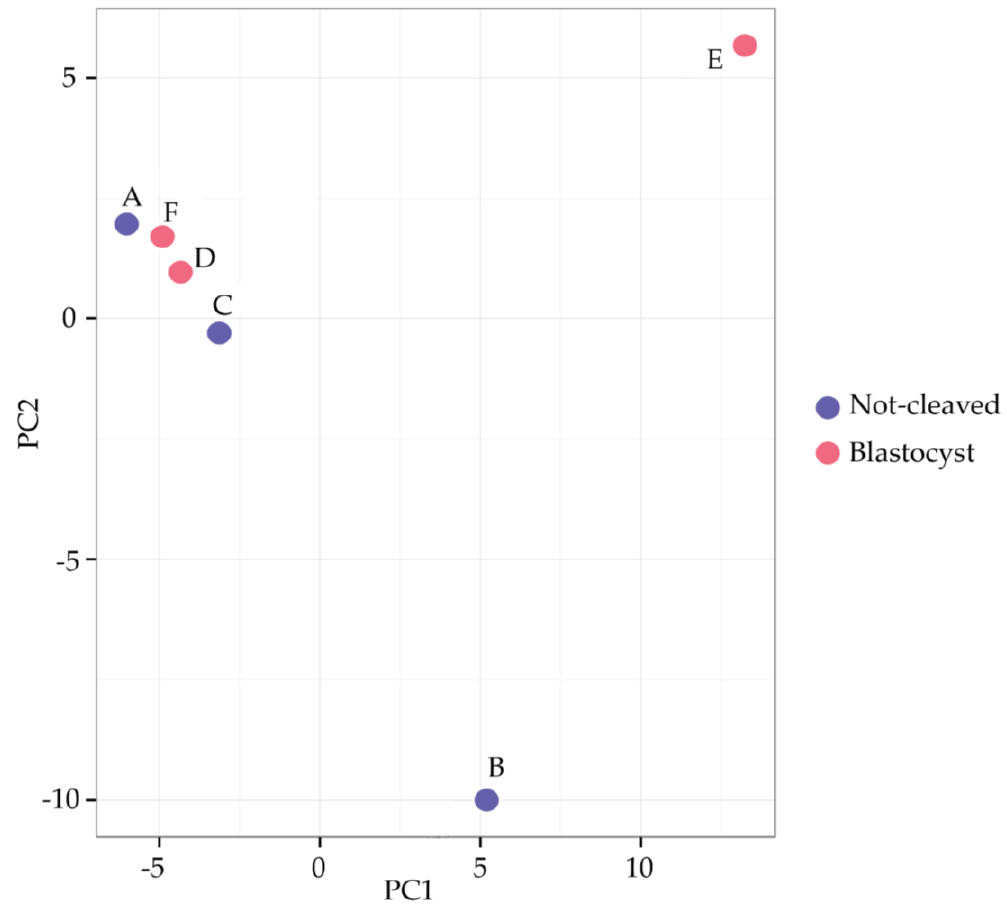
Figure 4. Principal component analysis (PCA) plot. The PCA was performed using the 50 miRNAs that had the largest variation across all samples. The features have been shifted to be zero centered (i.e., the mean value across samples was shifted to zero) and scaled to have unit variance (i.e., variance across samples was scaled to one) before the analysis. The groups do not cluster, not least because Samples B and E differ greatly from the rest for the primary component and from each other for the secondary component. Red circles = cumulus pieces surrounding oocytes that failed to cleave after exposure to sperm; blue circles = cumulus pieces surrounding oocytes that developed into blastocysts after fertilization.